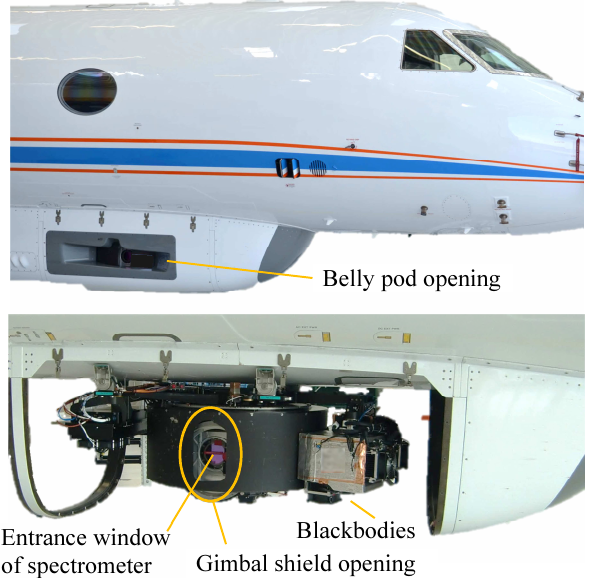
Figure 1. HALO with belly pod and opening for GLORIA (top) and belly pod with fairing dismounted showing the GLORIA instru- ment (bottom). The entrance window of the spectrometer is behind the opening in the gimbal’s shield.